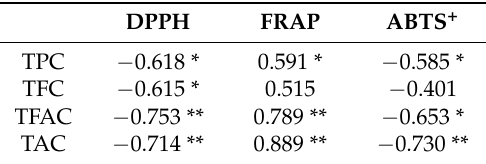
Table 3. Pearson’s correlation coefficients of phenolics (TPC, TFC, TFAC, and TAC) and antioxidant capacity (via DPPH, FRAP and ABTS + ) in the skins of ‘Tailihong’ and ‘Junzao’ jujube